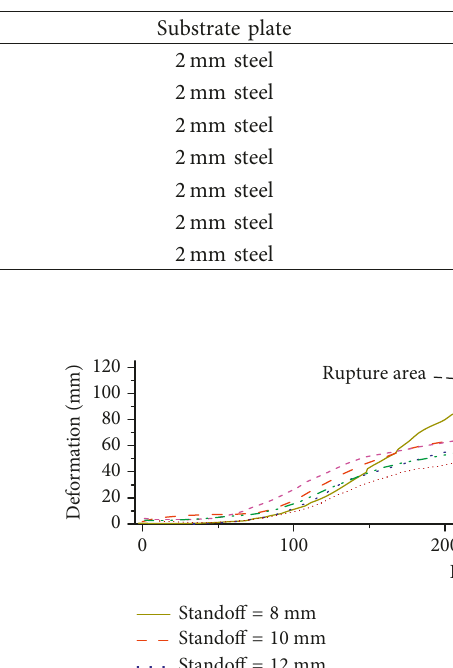
Table 5: Results of bare steel plates under different standoff.